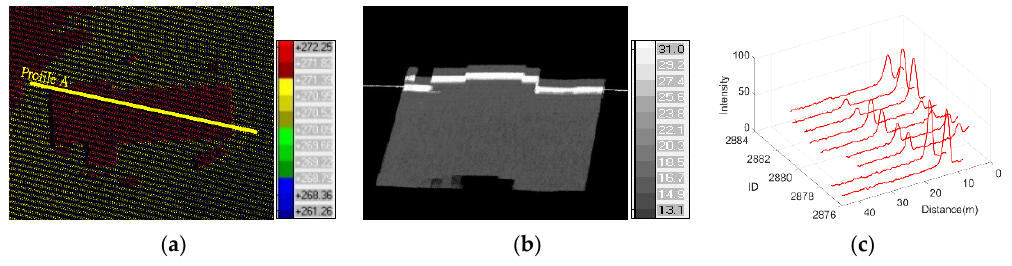
Figure 3. The illustration of the sequential waveforms: ( a ) Top view of lidar point clouds and colored by height in meter (the color bar indicate the height in meters); ( b ) Profile of sequential waveforms (the color bar indicate the intensity); ( c ) Sequential-waveform-covered tree.